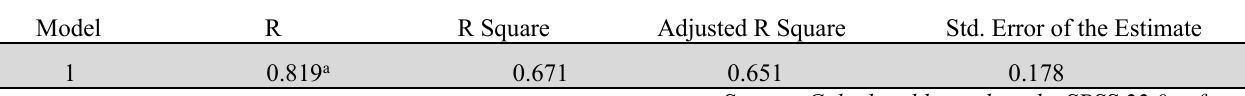
Model Summary R2 Model